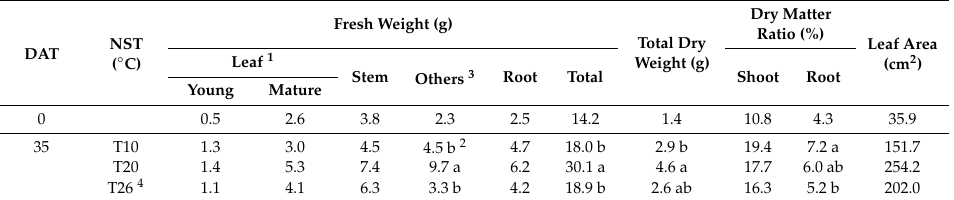
Table 3. E ff ects of nutrient solution temperature (NST) on growth of O. pumila at 35 days after start of the treatment (DAT) in experiment 2.